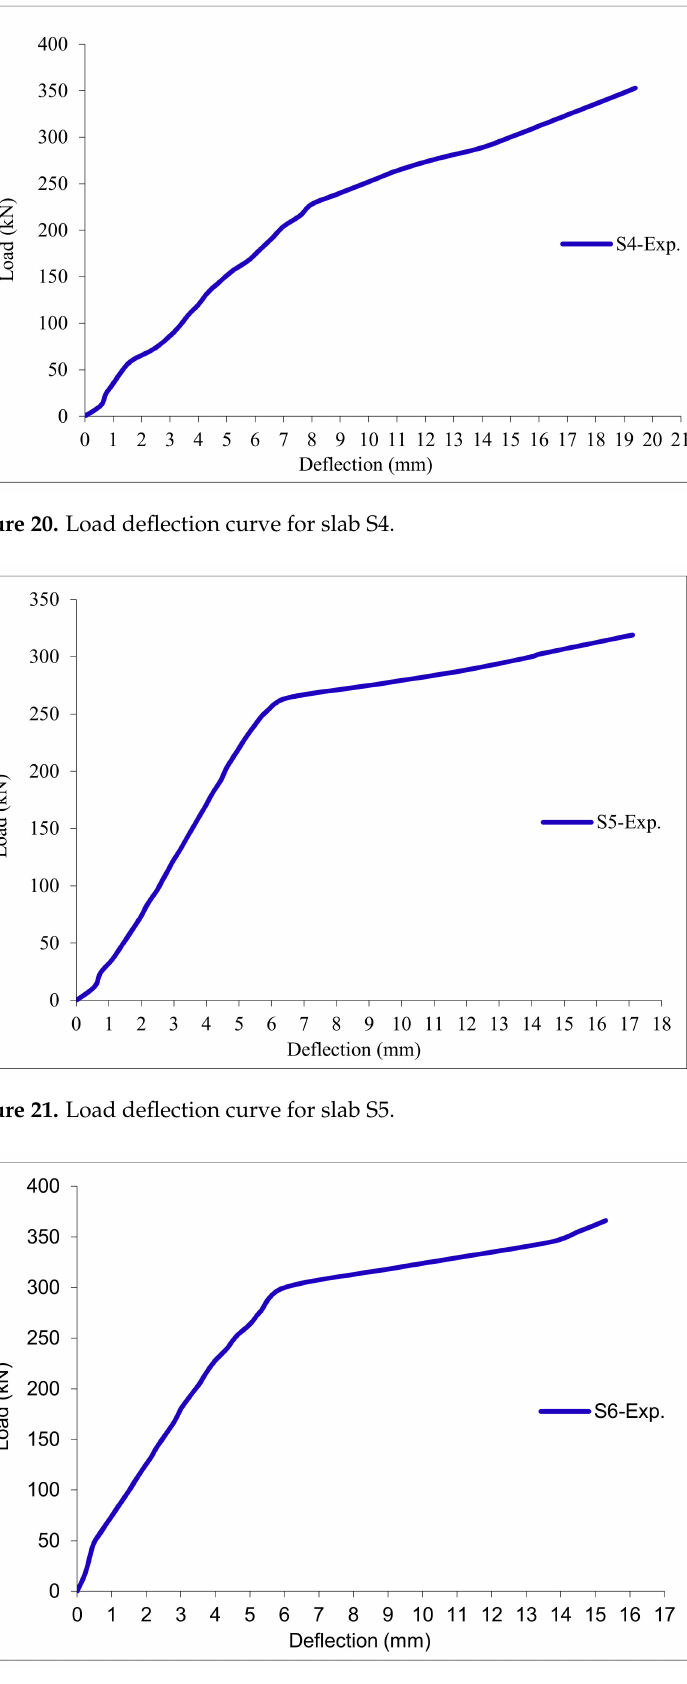
Figure 22. Load deflection curve for slab